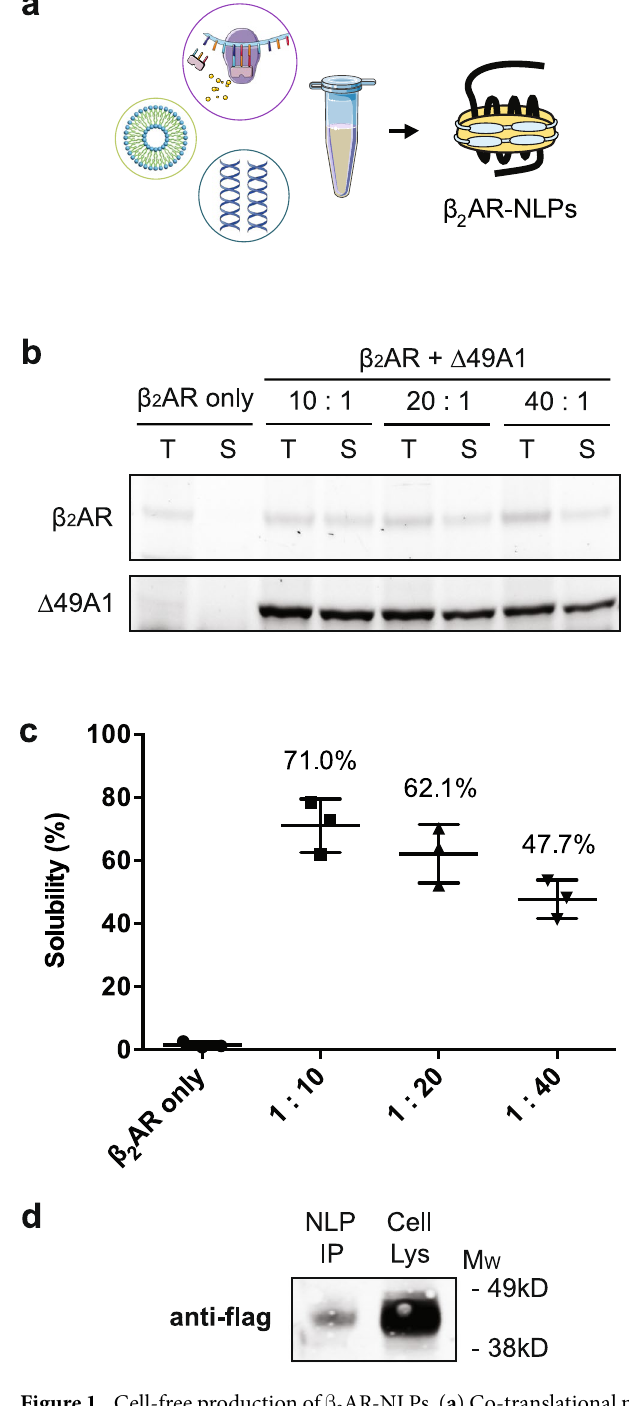
Figure 1. Cell-free production of β 2 AR-NLPs. ( a ) Co-translational production of β 2 AR-NLPs was achieved by incubating β 2 AR and ApoAI DNAs in the presence of synthetic lipid nanoparticles (1,2-dimyristoyl-sn- glycero-3-phosphocholine, DMPC) with the cell-free reaction mixture at 30 °C for 18 hours. ( b ) Optimization of the GPCR-NLPs in vitro translation system. β 2 AR was cell-free produced in the absence of Δ 49A1 cDNA and titrated in the presence of Δ 49A1 cDNA (10:1, 20:1, 40:1). FluoroTect ™ GreenLys (Promega) was added for visualizing newly synthesized proteins. Cell-free reactions were centrifuged at 10,000 rpm for 10 minutes. 5 μ l aliquots of sample before centrifugation (total fraction, T) and of the supernatant (soluble fraction, S) were used for SDS-PAGE. Gel images were taken using Molecular Imager ® Gel Doc ™ XR System from Biorad. ( c ) Band intensity ratio of the soluble vs. total cell-free produced β 2 AR was utilized to determine solubility. Results are shown as mean ± S.E. ( d ) The identity and molecular weight of cell-free expressed β 2 AR was verified by side-by- side comparison with cell-expressed β 2 AR, via western blot analysis using anti-flag